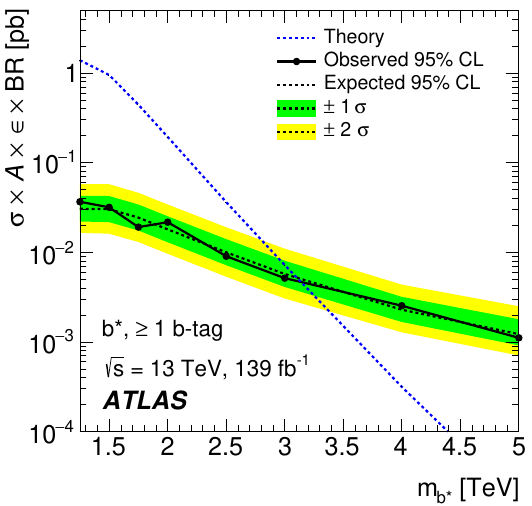
Figure 6 . The 95% CL upper limit on the cross-section times acceptance times b -tagging e(cid:14)ciency times branching ratio as a function of the mass of the b (cid:3) signal. The expected limit and corres- ponding (cid:6) 1 (cid:27) and (cid:6) 2 (cid:27) uncertainty bands are also shown. These exclusion limits are obtained using the 1 b category, with the selection described in the text and summarised in table